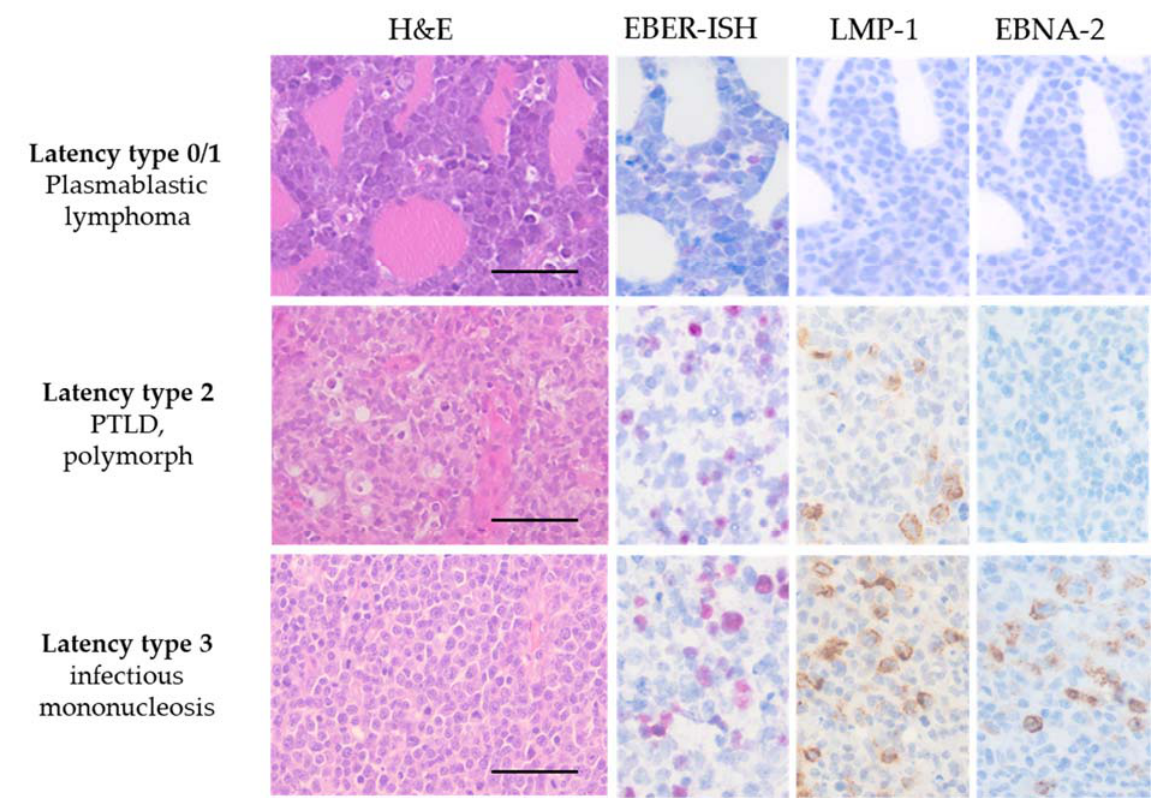
Figure 1. Micrographs of EBV-associated diseases using histopathological techniques. EBV latency type is correlated with EBV-associated diseases by using EBER-ISH and immunohistochemical stainings with antibodies against LMP-1 and EBNA-2. All latency types show positive signals in the EBER-ISH (pink nuclear signals). Plasmablastic lymphoma, latency type 0 or 1, is negative for LMP-1 or EBNA-2. In contrast, the polymorphic PTLD exhibits positive signals for LMP-1 (brown membranous signal), while immunohistochemistry (IHC) for EBNA-2 remains negative. In infectious mononucleosis, all three markers are positive, and thus a latency type III is determined. H&E stained micrographs show scale bars representing 50 µm.